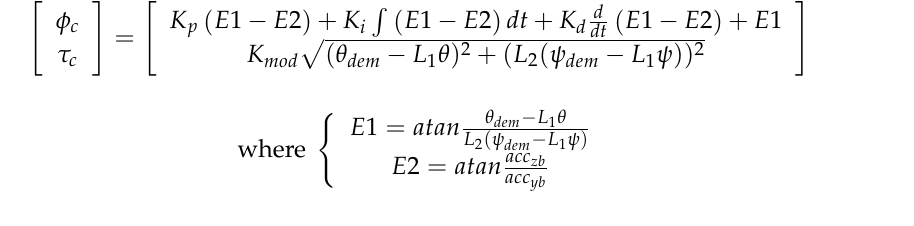
Table 5. Values for the constants of the control systems for each flight